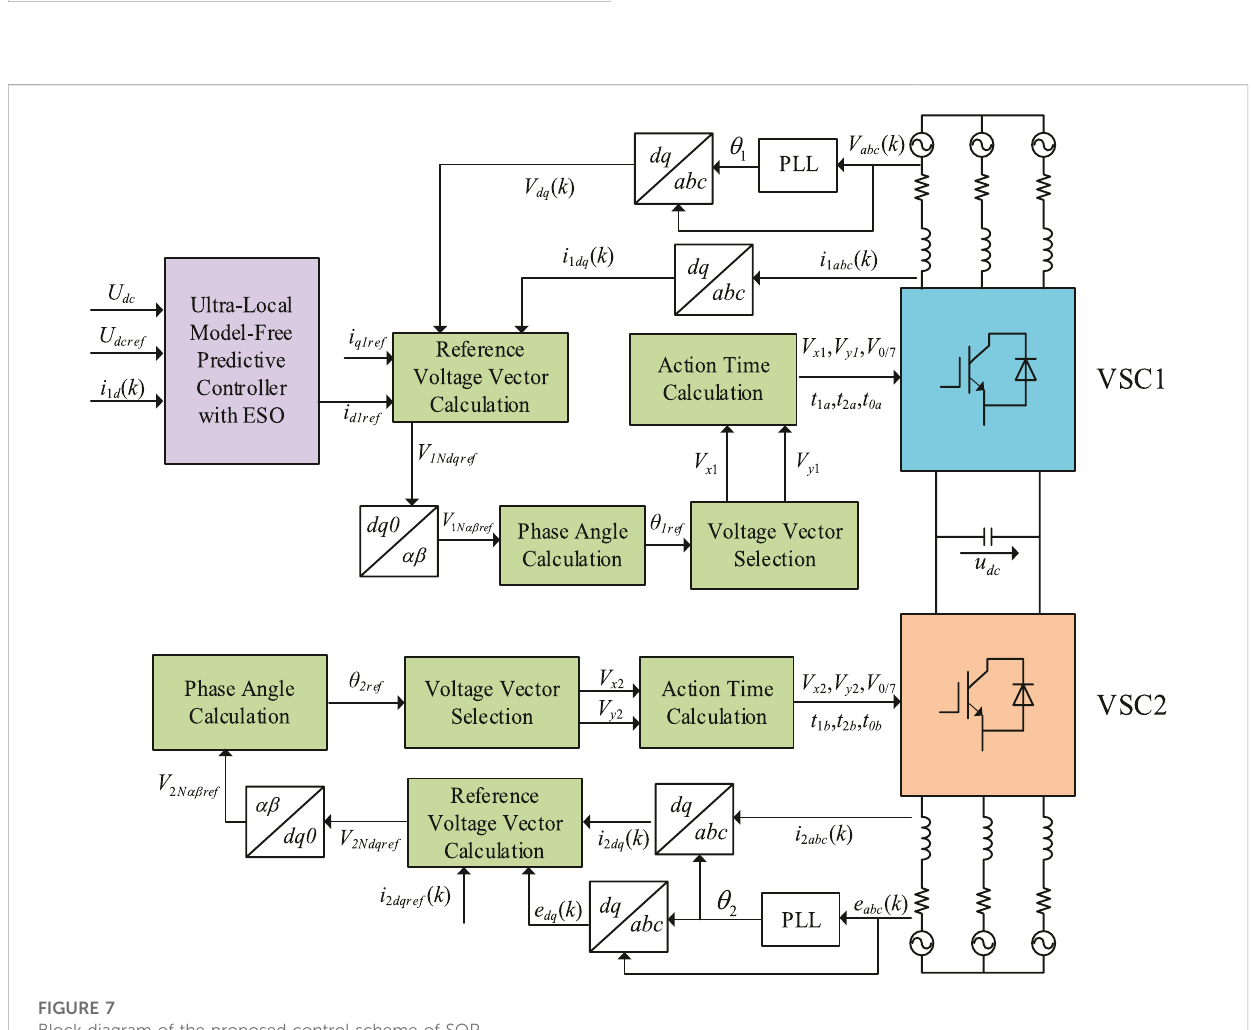
FIGURE 7 Block diagram of the proposed control scheme of